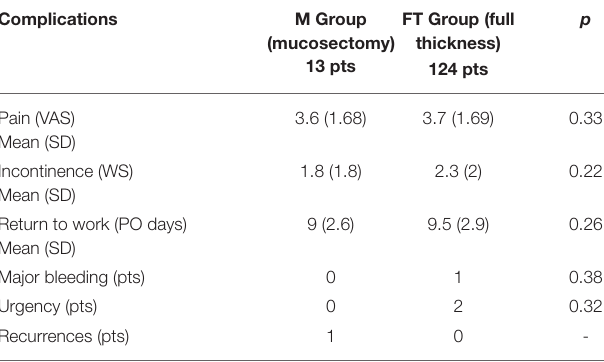
TABLE 2 | Minor and major complications after SH—mucosectomy vs. full